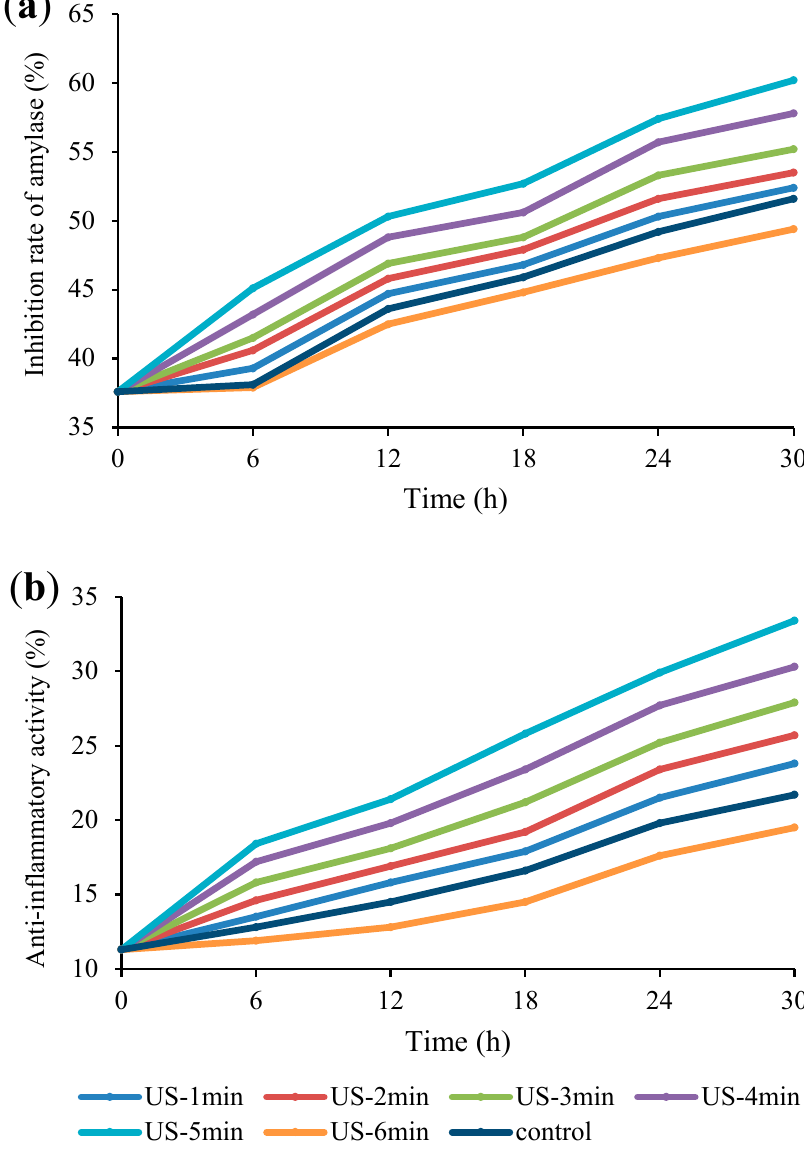
Figure 6. Anti-hyperglycemic ( a ) and anti-inflammatory ( b ) activities of US-treated and non-US treated Bakraei juice during fermentation. Error bars reveal the standard deviation of each measure- ment in Bakraei juice during 30 h of fermentation. US-1 min: ultrasound treatment for 1 min, Control: non-ultrasound treated juice.